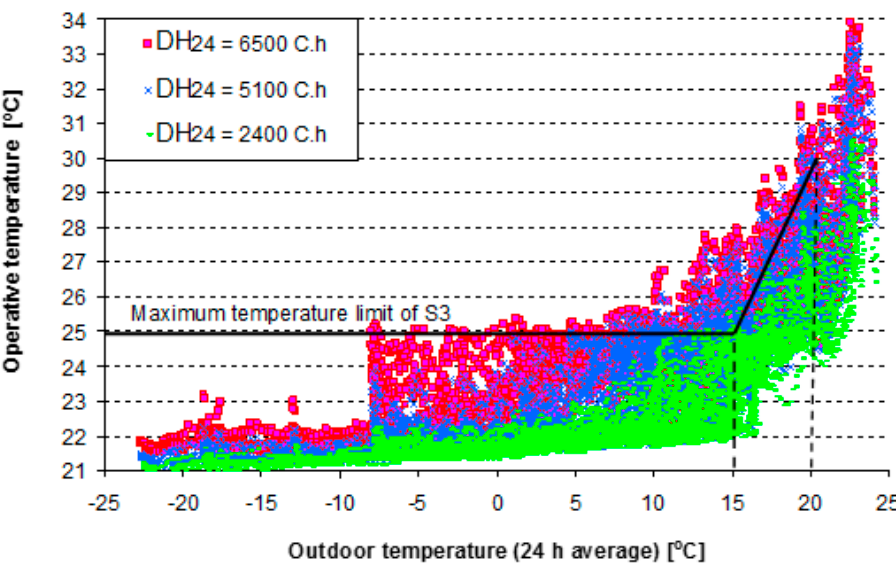
Figure 9. The operative air temperature assuming different levels of summer overheating (DH 24 ).